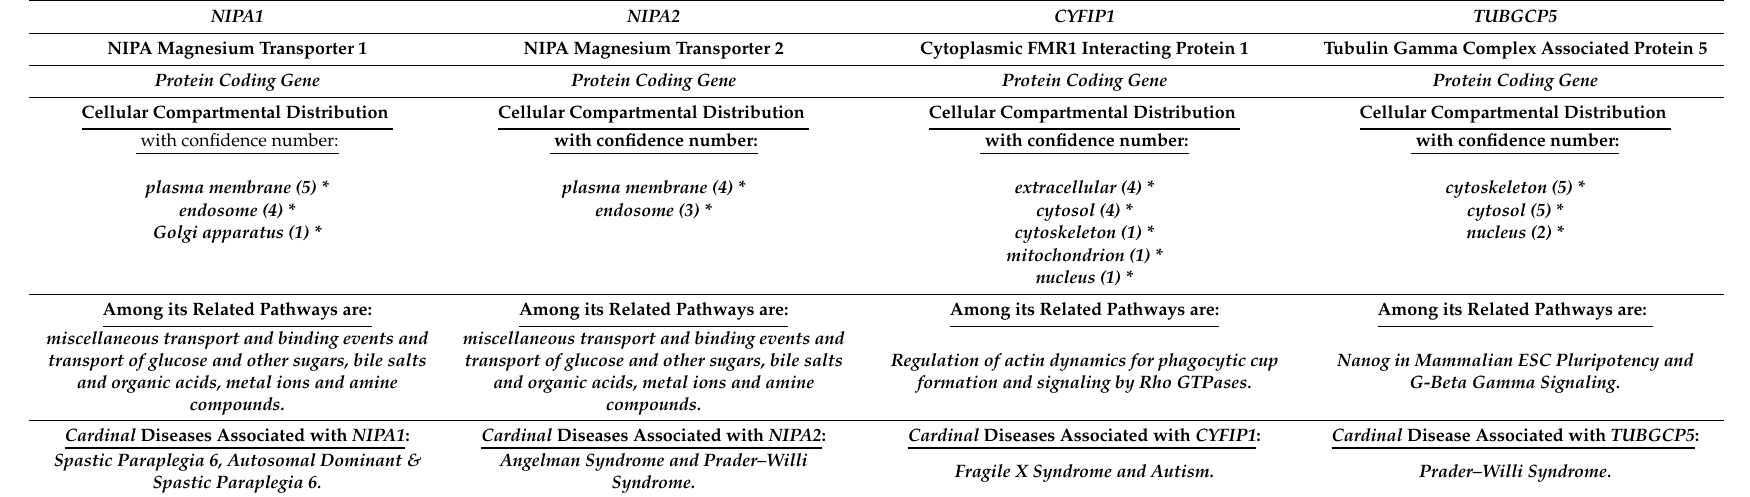
Table 15. Summary of Functions, Nature, Compartmentalization, Related Pathways, and Cardinal Diseases Associated with NIPA1 , NIPA2 , CYFIP1 , and TUBGCP5 Genes in the 15q11.2 BP1-BP2